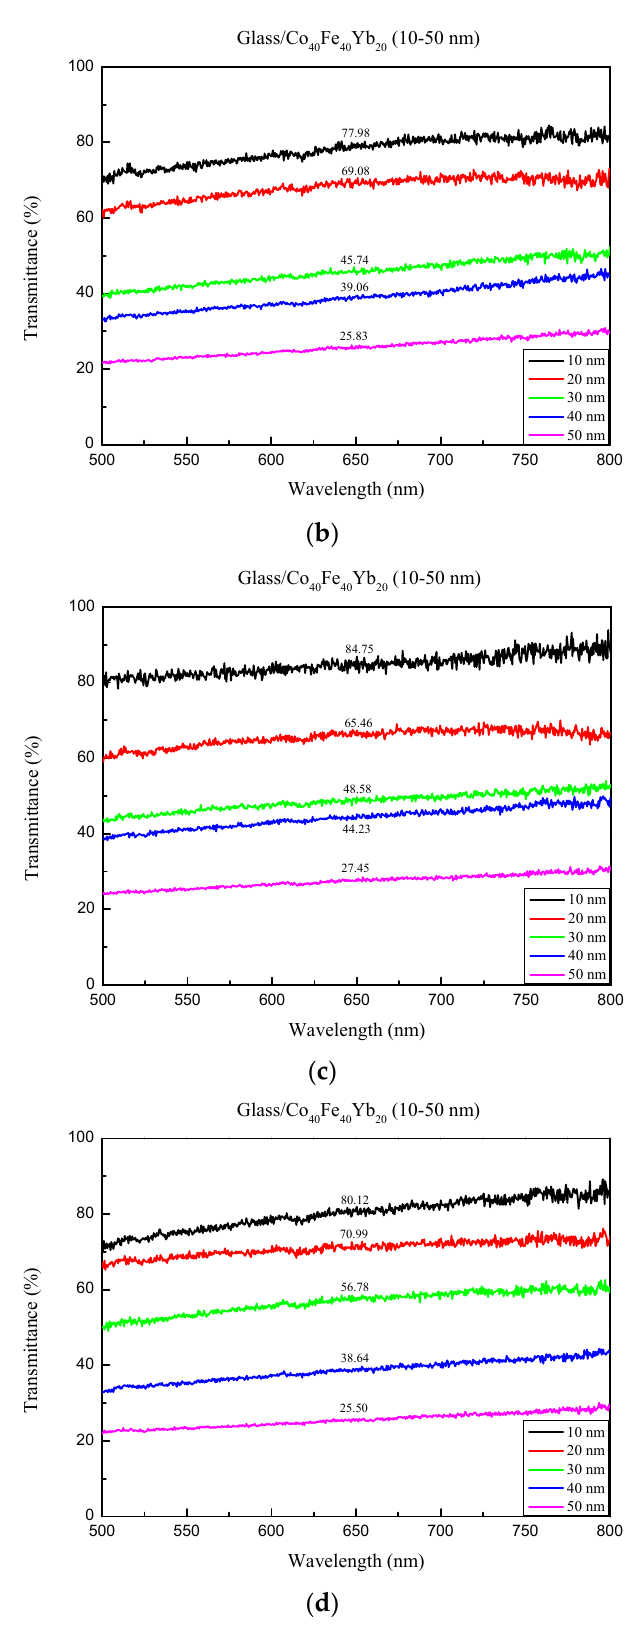
Figure 4. Transmittance of Co 40 Fe 40 Yb 20 films. ( a ) RT, ( b ) following annealing at 100 °C, ( c ) following annealing at 200 °C, and ( d ) following annealing at 300 °C.